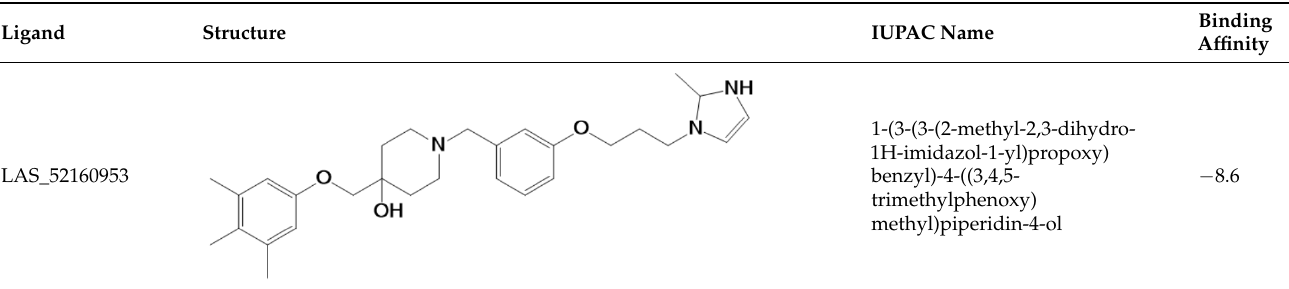
Table 1. Compounds identified via virtual screening that showed stable binding affinity for TgAPN2 binding